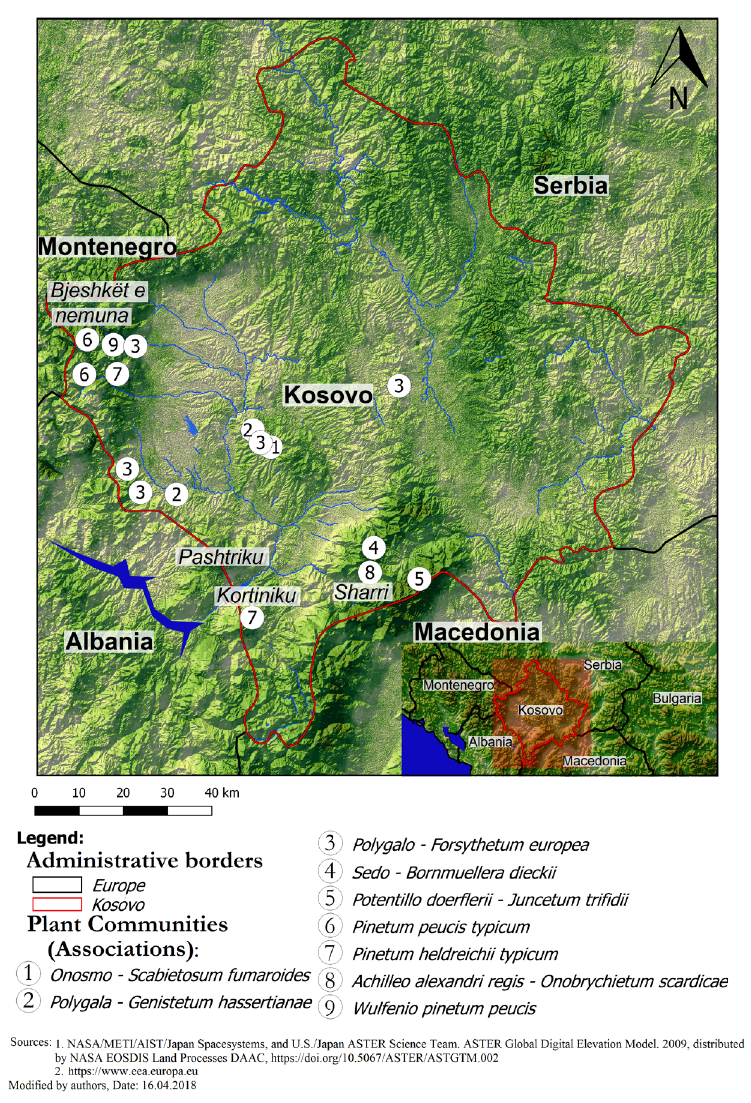
Figure 3: Endemic and endemic-relict plant species associations in